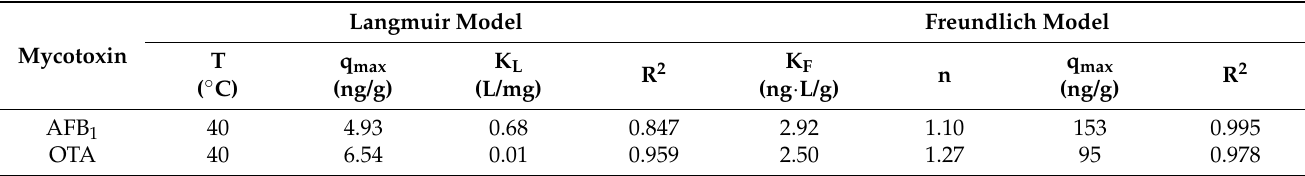
Figure 6. Freundlich isotherm plot during sorption of mycotoxins with the adsorbent (at 40 °C and pH 5). Table 4. Langmuir and Freundlich parameters for the adsorption of mycotoxins with MGO (at 40 ◦ C, 5 h, and pH 5). Langmuir Model Freundlich Mycotoxin